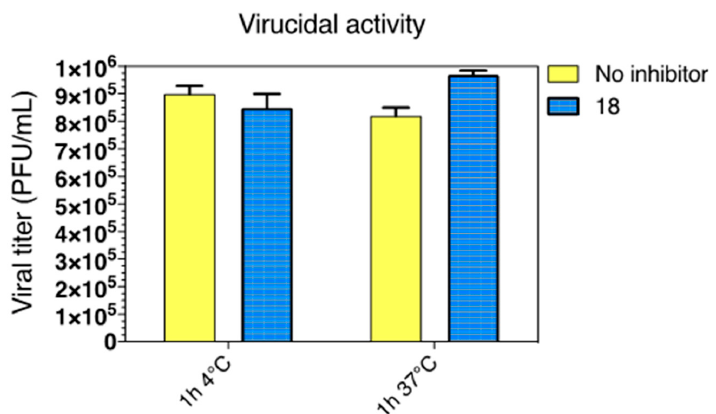
Figure 8. Virucidal activity (expressed as plaque-forming units (PFU/mL) of benzotriazole 18e (20 μ M) against CVB5 infectivity at either 4 °C or 37 °C for 2 h. Blue columns, viral titer for benzotriazole (20 µ M) against CVB5 infectivity at either 4 ◦ C or 37 ◦ C for 2 h. Blue columns, viral titer for 18e and viral solution; yellow columns indicate the viral titer of untreated solution. benzotriazole 18e and viral solution; yellow columns indicate the viral titer of untreated